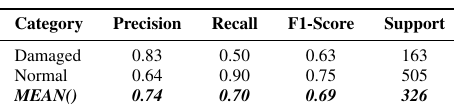
the classes. Five dataset are evaluated: unbalanced “Photovoltaic images Dataset”, balanced “Photovoltaic images Dataset”, “Pho- tovoltaic images Dataset” with flipped images left-to-right and top-to-bottom, “Photovoltaic images Dataset” with rotated im- flipped and rotated